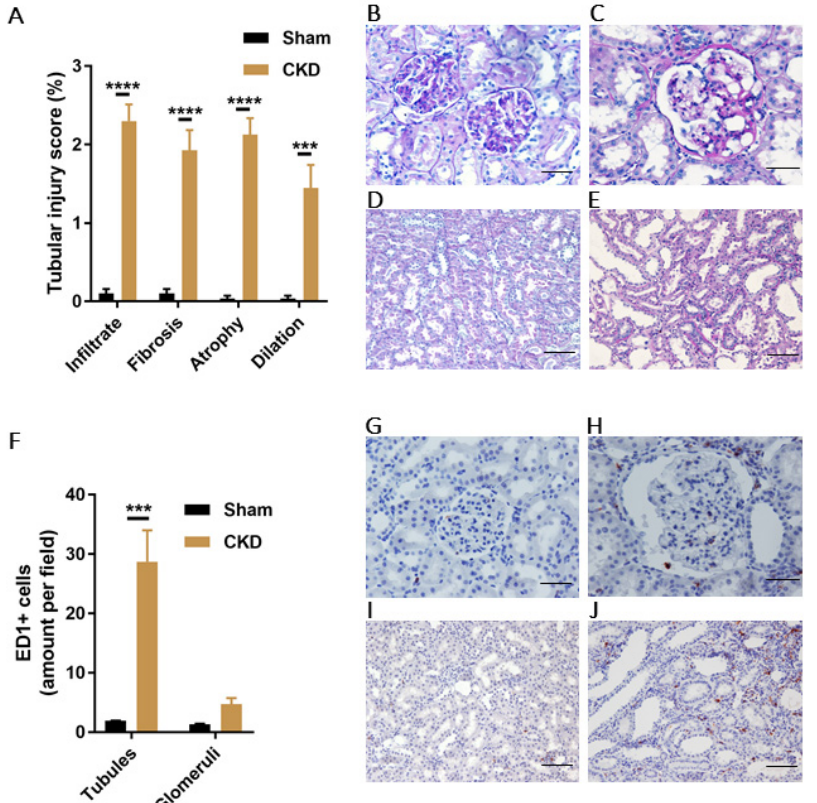
Figure 6. Characteristics of the CKD model in female Sprague Dawley rats created using single- procedure SNX. ( A ) Tubular injury score (%) in CKD and Sham rats, characterized by infiltrate, tubular fibrosis, atrophy and dilation. Representative PAS-staining images of glomeruli (20 × ) in ( B ) Sham and ( C ) CKD rats. Scale bars 50 µ m. Representative PAS-staining images of tubules (10 × ) in ( D ) Sham and ( E ) CKD rats. Scale bars 100 µ m. ( F ) Quantification of ED1 positive cells in tubules and glomeruli of Sham and CKD rats. Representative images of ED1 staining in glomeruli (20 × ) of ( G ) Sham and ( H ) CKD animals. Scale bars 50 µ m. Representative images of ED1 staining in tubules (10 × ) of ( I ) Sham and ( J ) CKD animals. Scale bars 100 µ m. Data are derived from n = 3 Sham and n = 4 CKD animals and presented as mean ± SEM. *** p < 0.001, **** p < 0.0001 (Two-way ANOVA followed by Sidaks’s multiple comparison